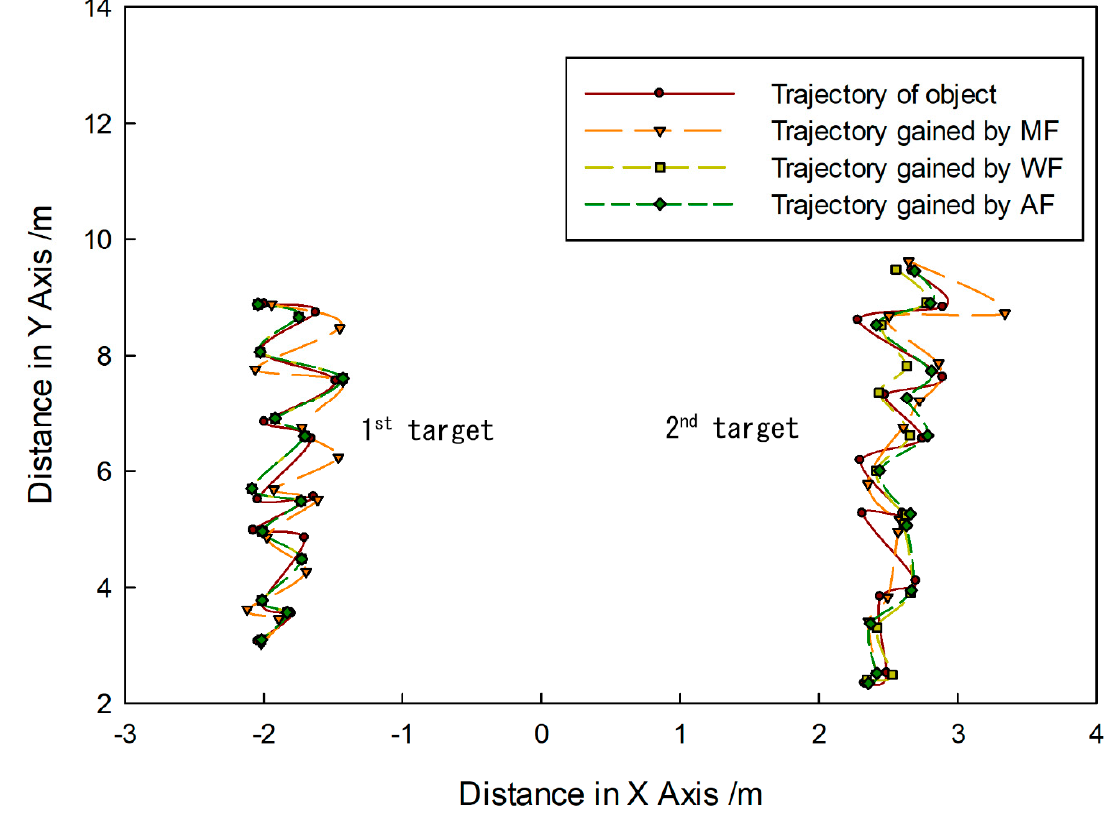
Figure 15. Tracking trajectory gained by different fusion methods.